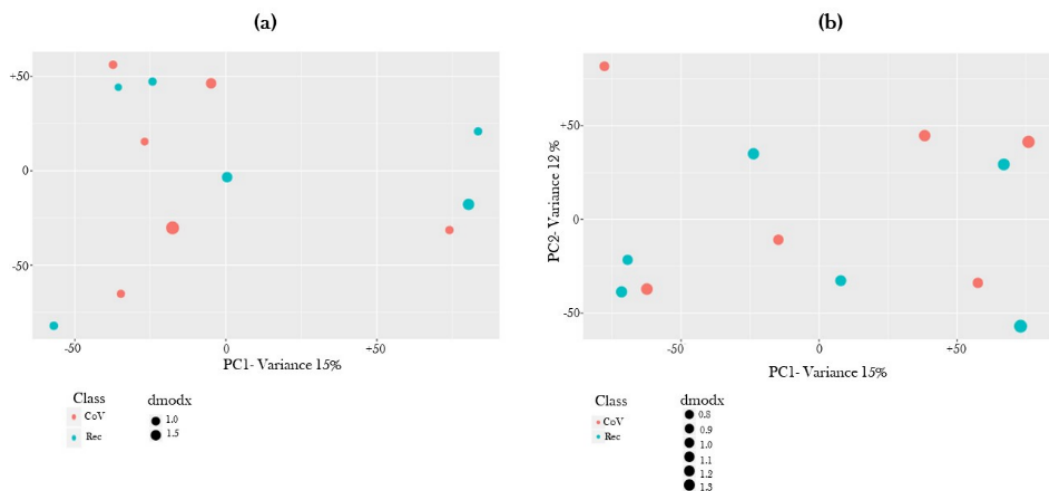
Figure 2. Principle component plot for COVID-19-positive and COVID-19-recovered patient serum samples. Principle component plot of ( a ) positive and ( b ) negative ion modes based on differential levels of metabolites in the serum samples from COVID-19-positive and COVID-19-recovered patients as quantified using ultra-performance liquid chromatography mass spectrometry (UPLC-MS).